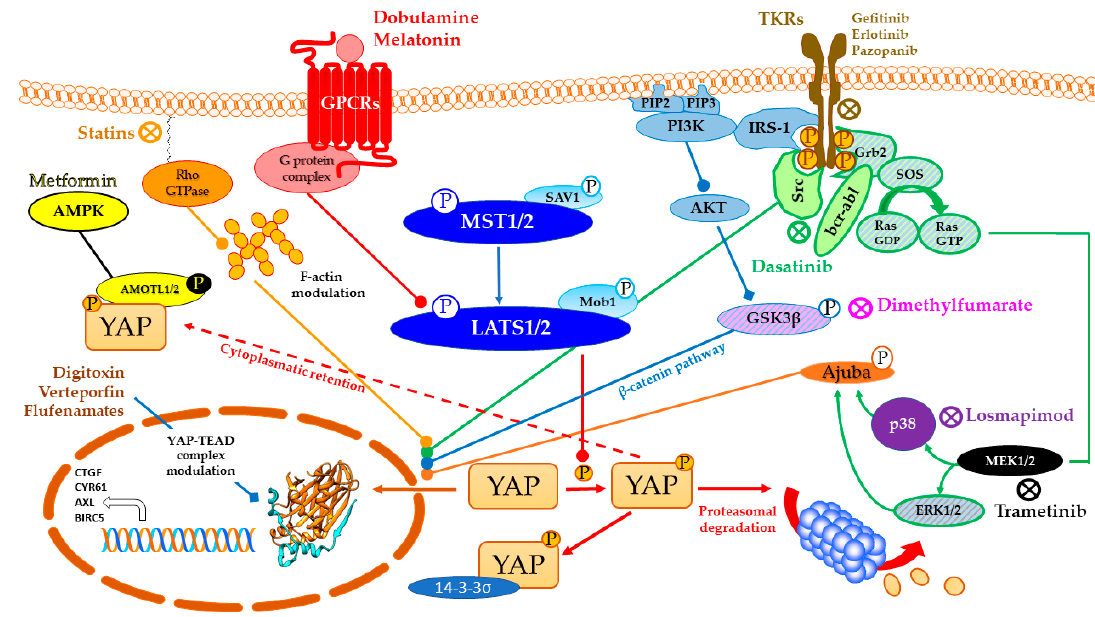
Figure 3. Repurposing of drugs on YAP (Yes-1 associated protein)-TEAD (transcriptional enhanced associate domain) system through cross-talking pathways. Hippo pathway core kinases (in blue) and final effector YAP are modulated by approved drugs through different cross-talking pathways.